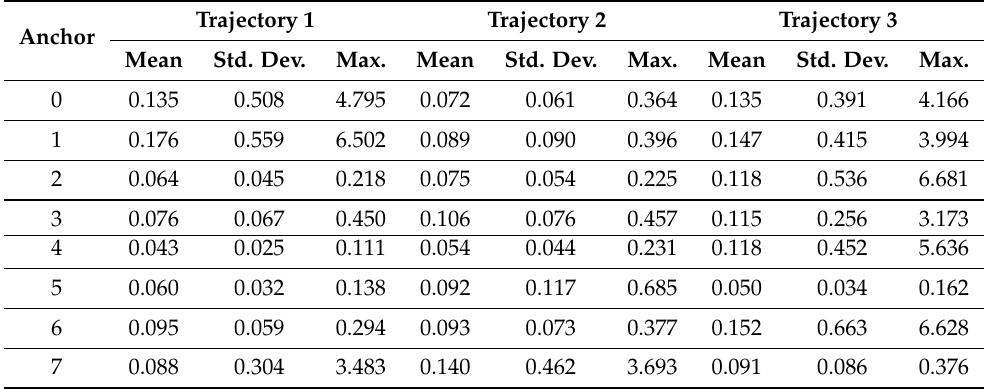
Table 1. Discrepancy between true tag-anchor ranges and measured ranges as supplied by the UWB kit involved in the laboratory experiments. All values are in